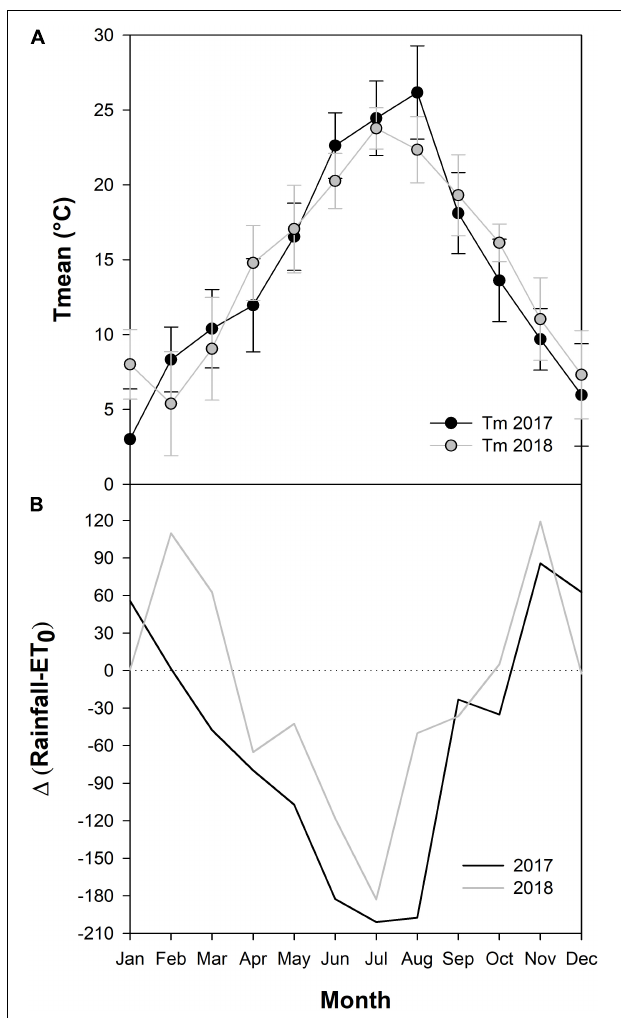
FIGURE 1 | Diagrams showing the monthly average mean air temperature (A) and water deficit (calculated as difference between rainfall and ET0) (B) for 2017 (black line) and 2018 (gray line).